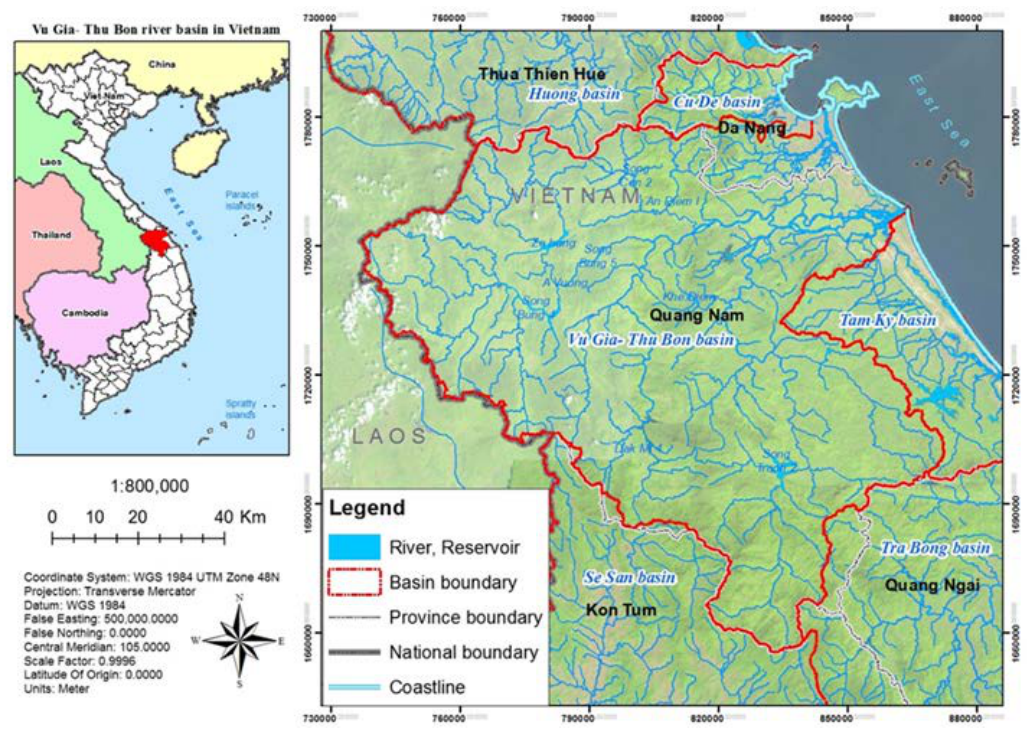
Figure 1. Geographic location of the Vu Gia-Thu Bon (VGTB) river basin [21] (reproduced with permission from Nguyen Kim Loi, Nguyen Duy Liem, Le Hoang Tu, Nguyen Thi Hong, Cao Duy Truong, Vo Ngoc Quynh Tram, Tran Thong Nhat, Tran Ngoc Anh, and Jaehak Jeong, Journal of Water and Climate Change; published by IWA Publishing, 2019).